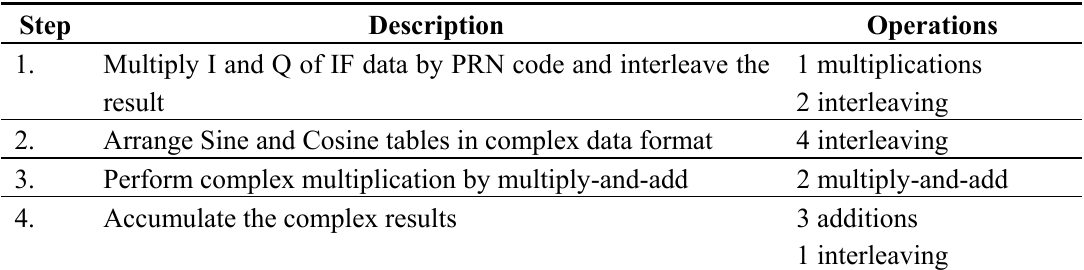
Table 2. Procedure to implement software correlator with complex IF data for a single sample.